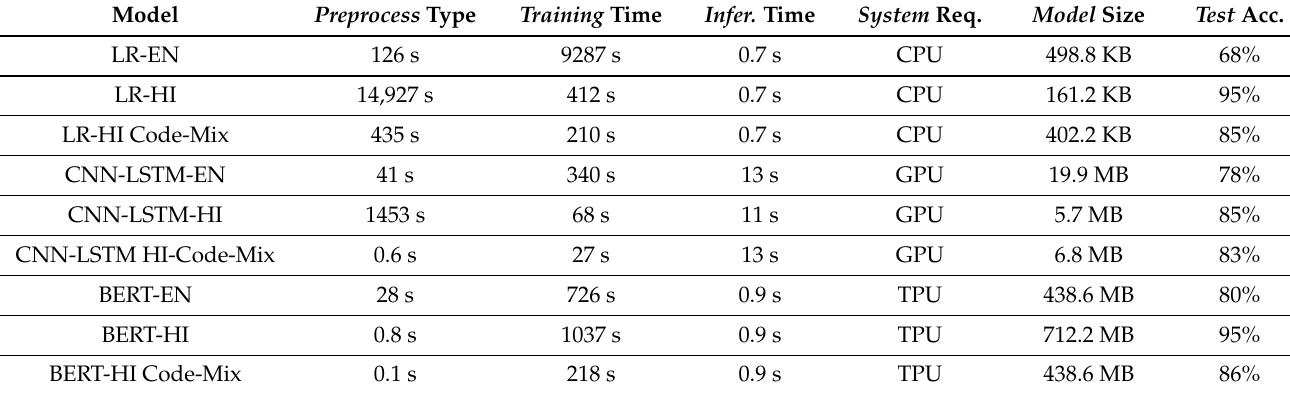
Table 9. Model evaluation and performance